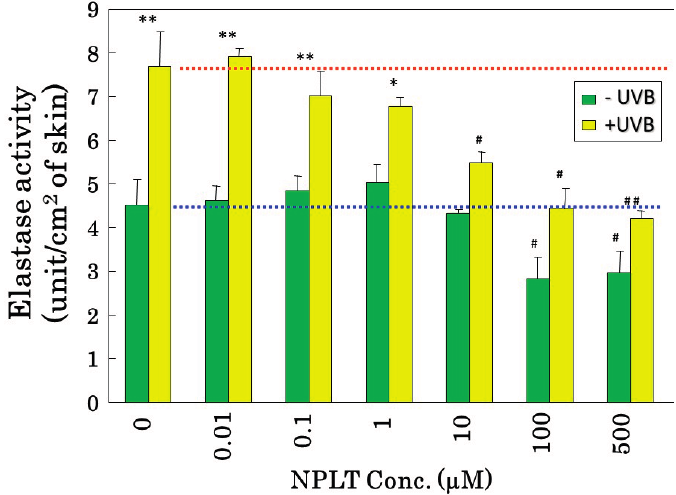
Figure 8. Inhibitory effect of NPLT on hairless mouse skin elastase stimulated by UVB irradiation. Hairless mouse skin was biopsied 24 h after 6 weeks of UVB irradiation or age-matched control, homogenized, and processed for elastase activity. NPLT was used at the indicated concentrations. The UVB radiation was carried out in the same conditions described in the legend of Figure 6. * p < 0.05; ** p < 0.01 ( vs. control); # p < 0.05; ## p < 0.01 ( vs. 0 mM NPLT). Data represent mean ±